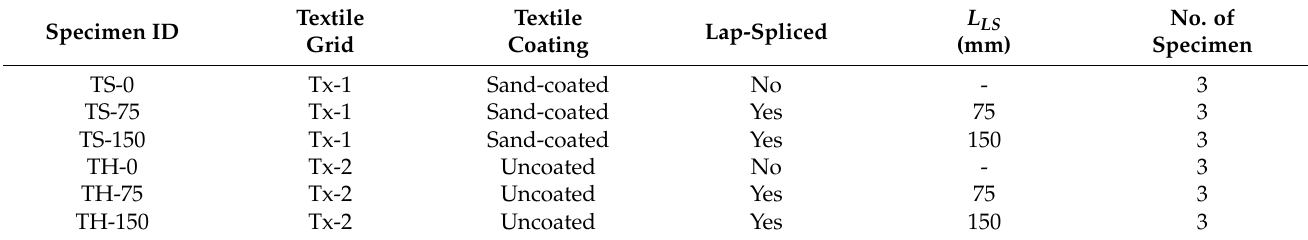
Figure 2. Coupon specimen for direct tension test: ( a ) dimensions (units, mm); ( b ) coupon without textile lap splicing; ( c ) coupon with lap splicing. Table 3. Characteristic of direct tension test specimens.